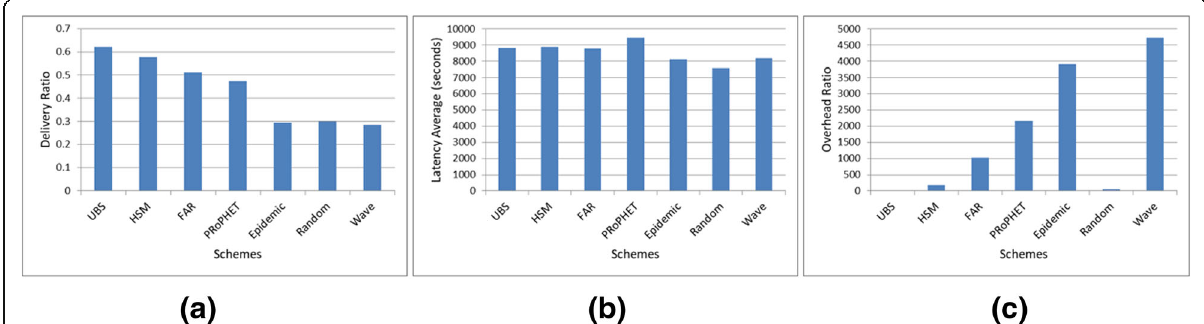
Fig. 13 The performance evaluation on real connectivity trace data